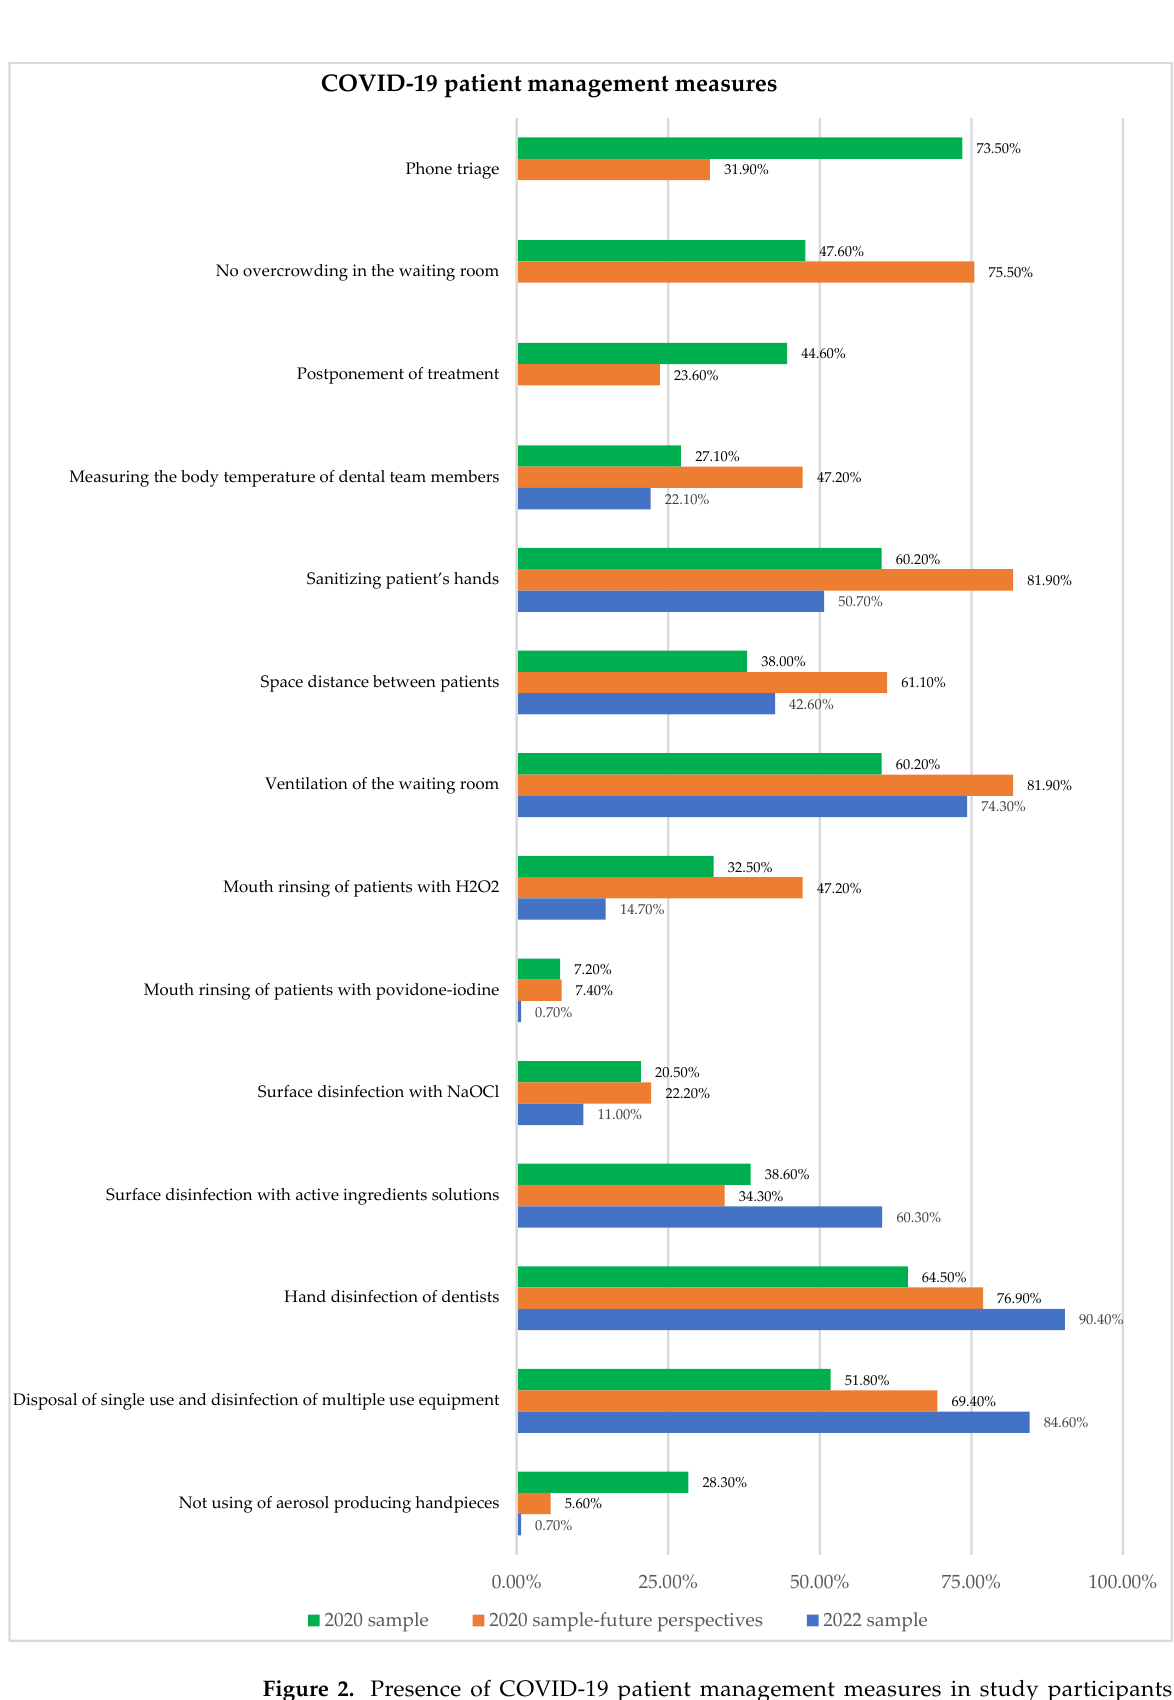
Figure 2. Presence of COVID-19 patient management measures in study participants which mostly differed.